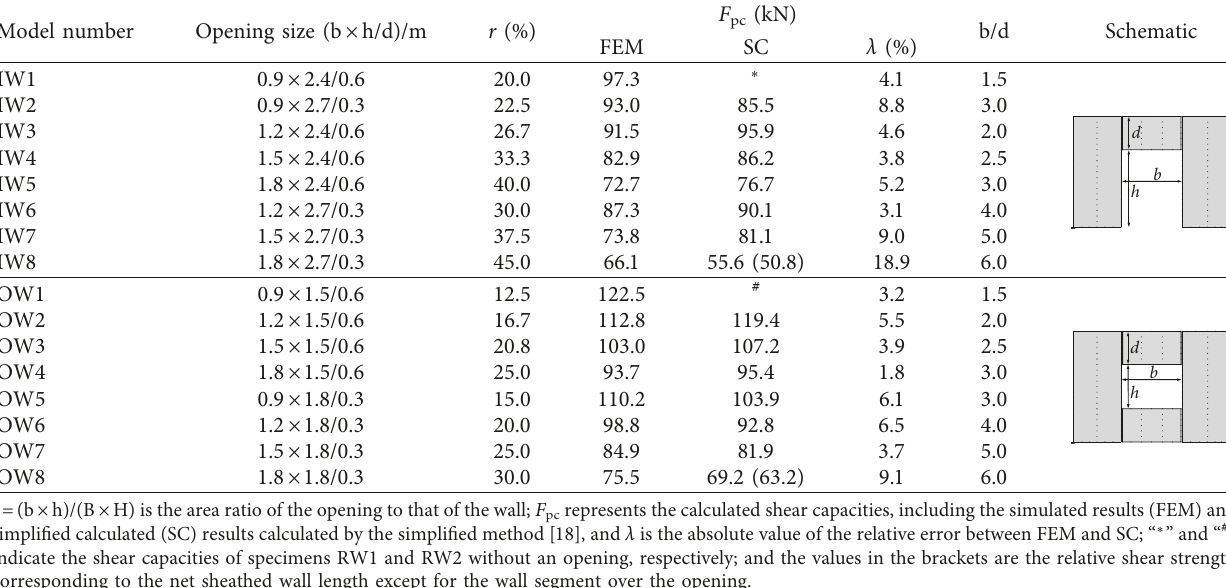
Table 5: Details of sixteen numerical models.